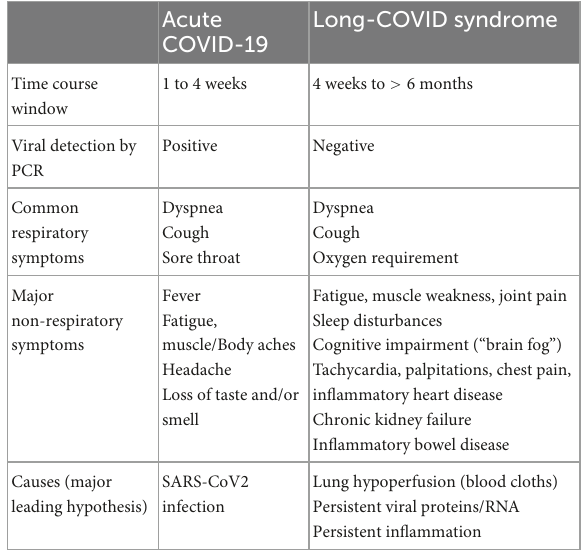
TABLE 1 Main characteristics of acute-COVID and long-COVID